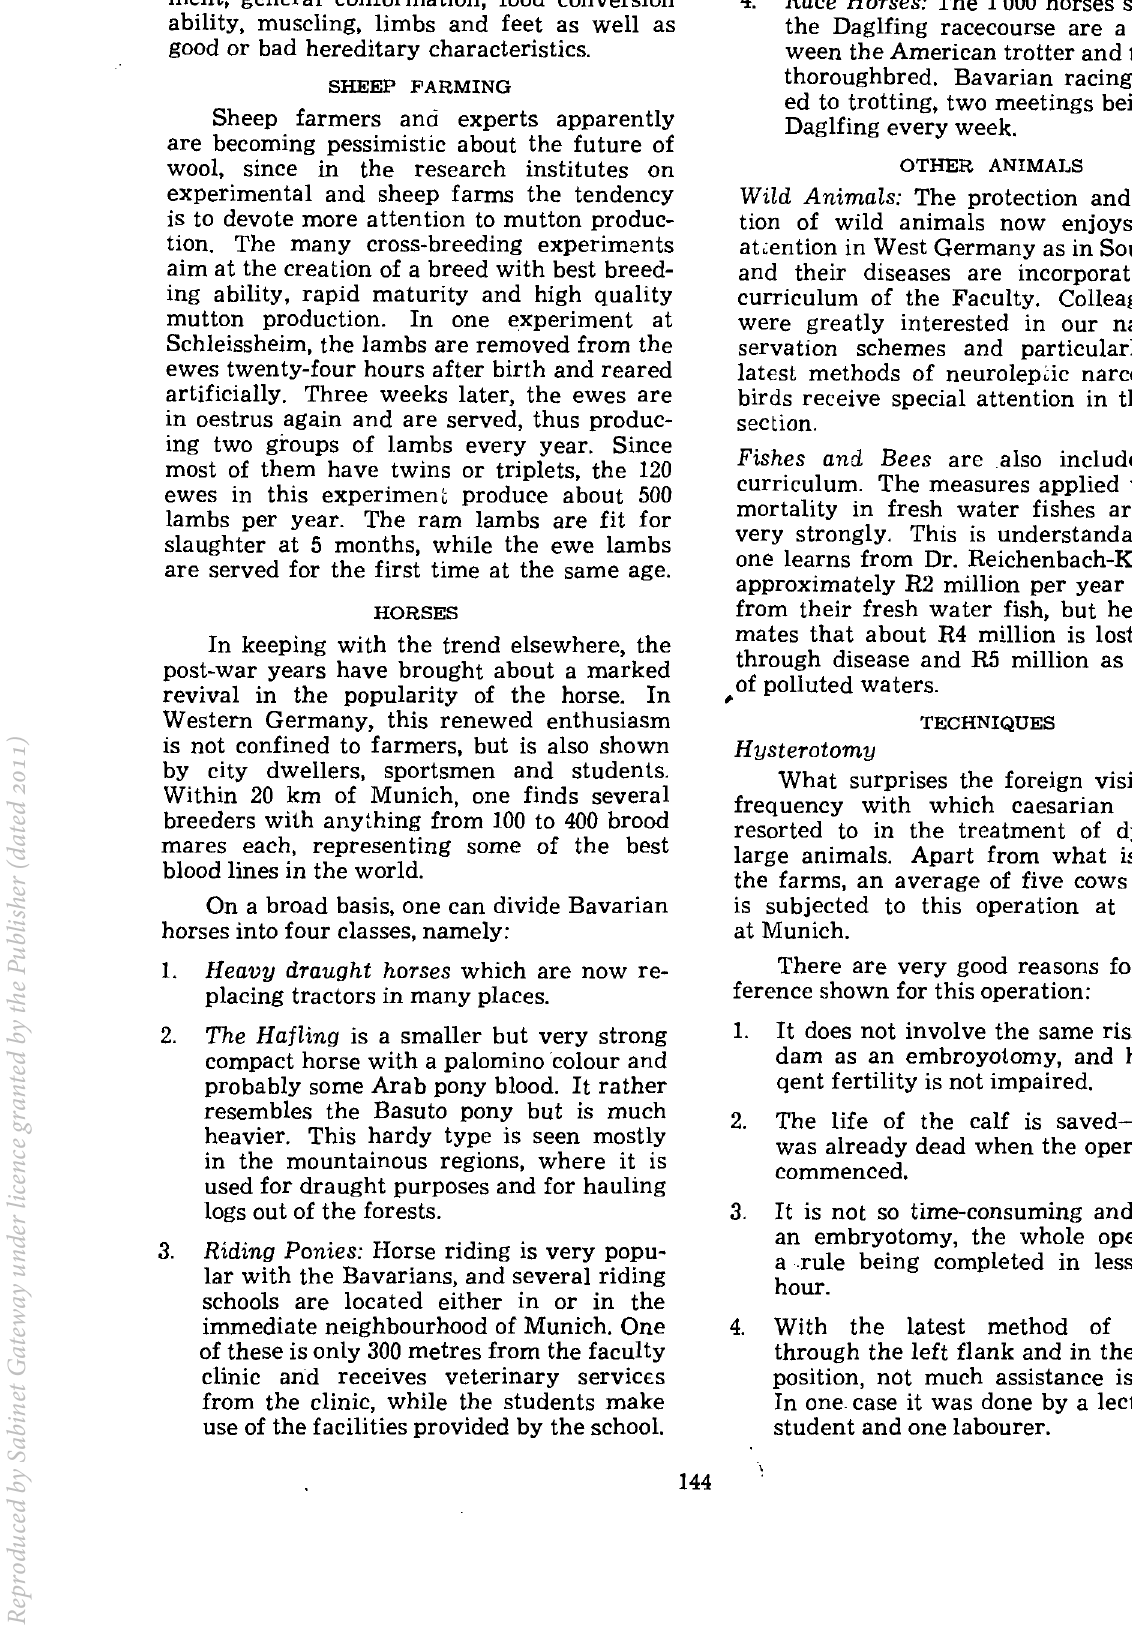
Race Horses: The 1000 horses standing at the Daglfing racecourse are a cross bet ween the American trotter and the French thoroughbred. Bavarian racing is